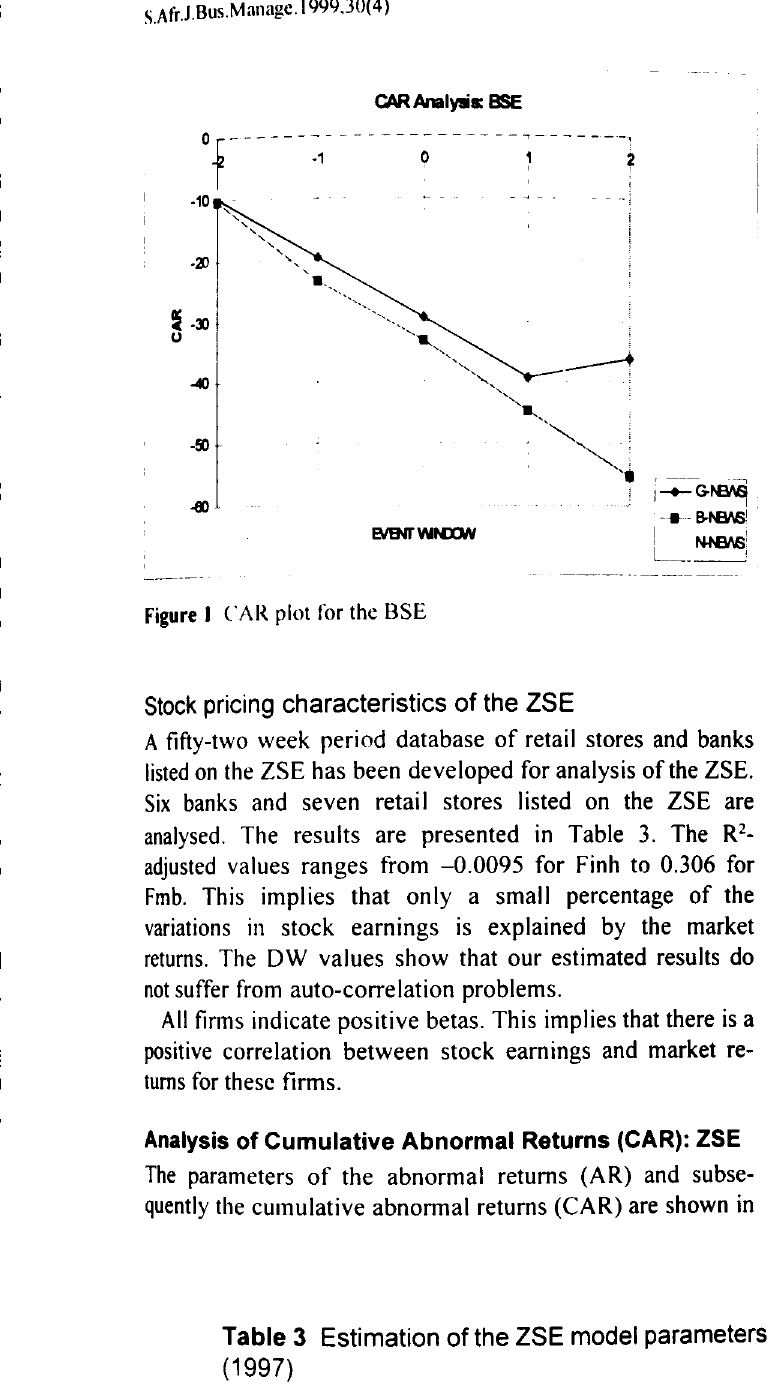
Table 3 Estimation of the ZSE model parameters using equal weighted market returns for 52-weeks